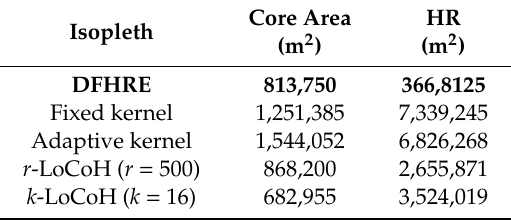
Table 2. Sizes of the core areas and HRs estimated by the DFHRE, KDE and LoCoH methods for Dataset 2.